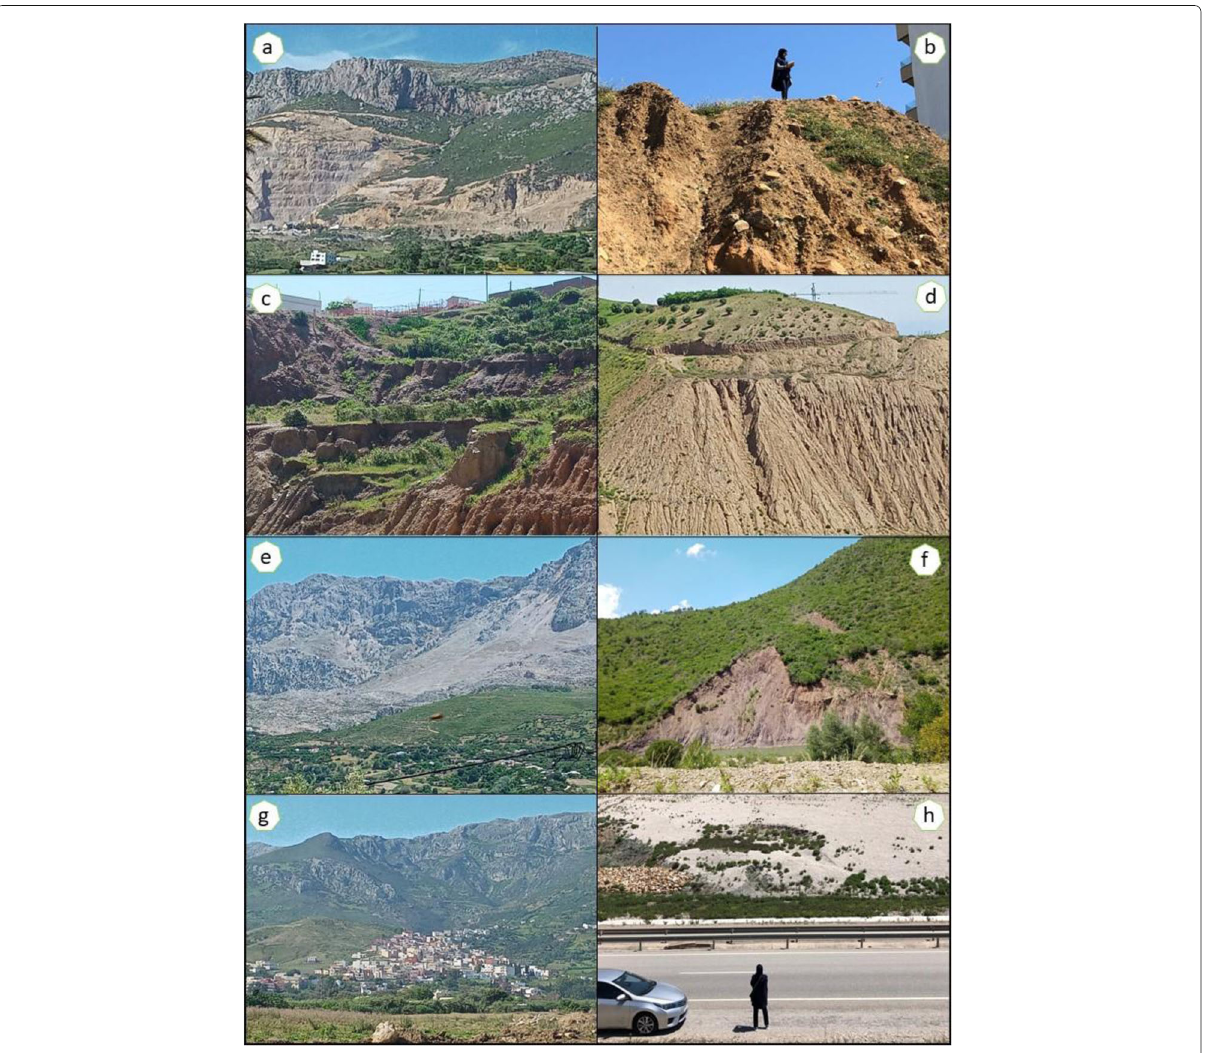
Fig. 2 a,b,c,d,e,f Examples of mass movements along the road networks of the province of Tétouan: a road N2, Tétouan (35°33’25.3"N 5°24’46.3"W),